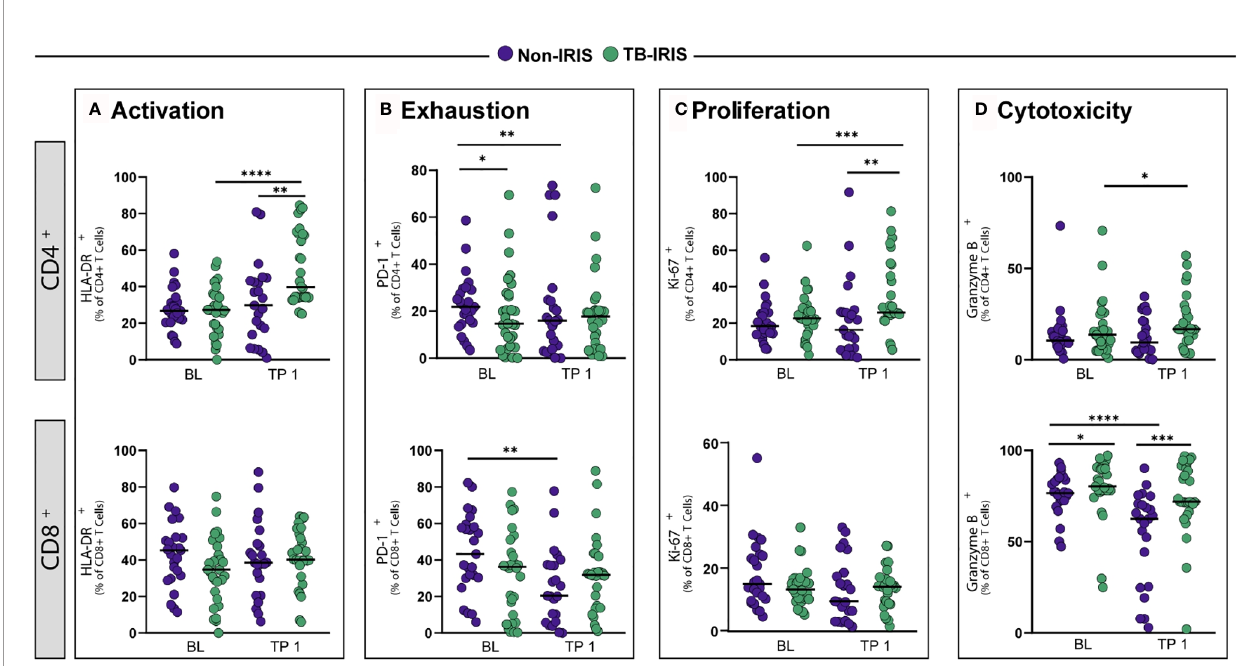
FIGURE 2 | Evaluation of T lymphocyte activation markers in TB-HIV co-infected patients prior to and following ART initiation. Expression of fl ow cytometry markers related to T cell activation (HLA-DR) (A) , exhaustion (PD-1) (B) , proliferation (Ki67) (C) , and cytotoxicity (Granzyme B) (D) were assessed in whole blood samples from TB- HIV co-infected individuals at baseline (BL) pre-ART and at the time of TB-IRIS manifestation (Timepoint [TP]1), which was 2-6 weeks on ART. Data were analyzed using the Mann-Whitney test or Wilcoxon matched-pairs test for paired analyses within each study group (*p < 0.05, **p < 0.01, ***p < 0.001, ****p <